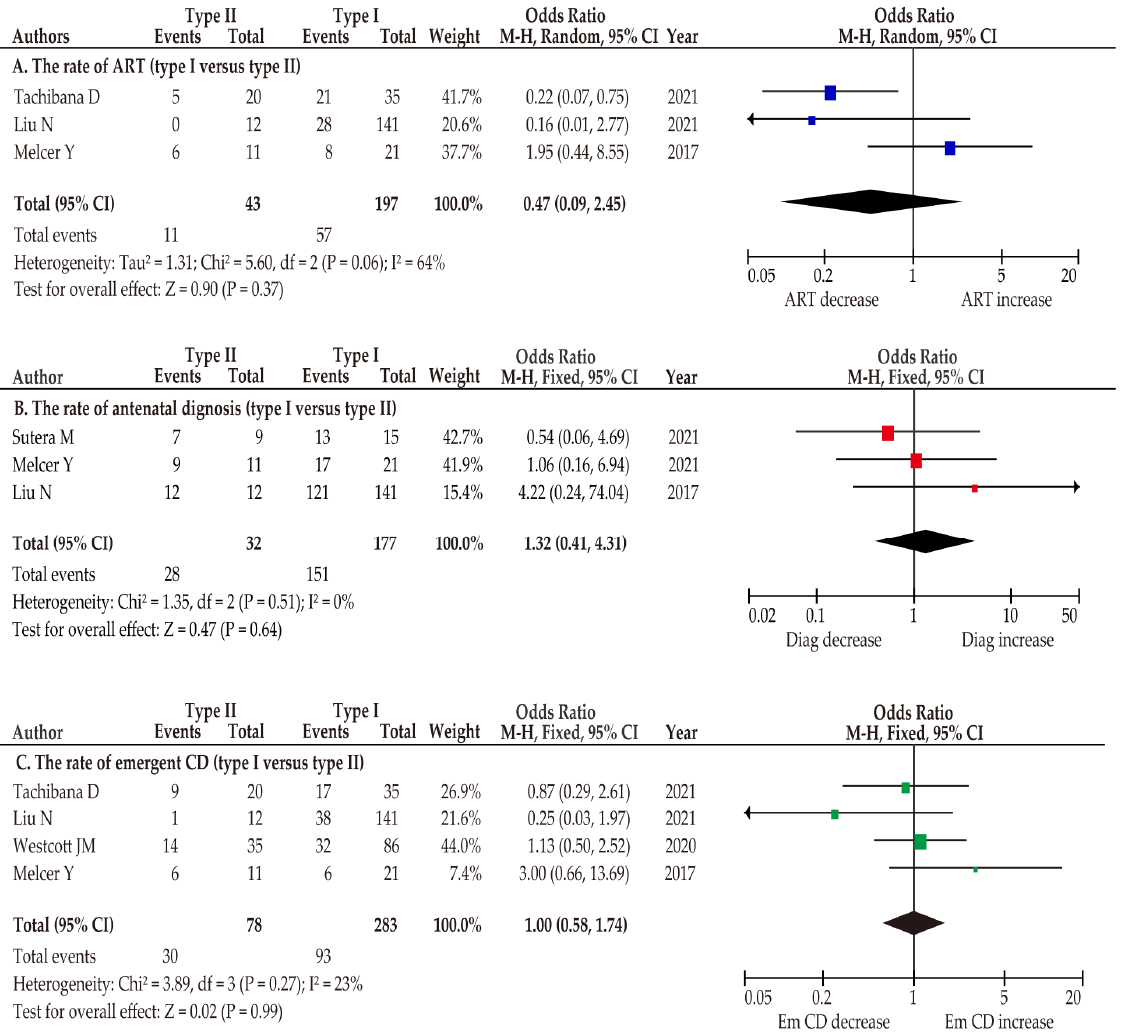
Figure 2. Meta analysis of the characteristics and outcomes of type I and type II vasa previa. The pooled odds ratios for ( A ) the rate of ART (unadjusted), ( B ) the rate of antenatal diagnosis (unad- justed), ( C ) the rate of emergent cesarean delivery (unadjusted), and ( D ) gestational age at delivery between women with type I and type II vasa previa are shown. Forest plots were ordered by the year of publication and relative weight (%) of the study within the strata. The heterogeneity among the studies in each analysis was as follows: substantial heterogeneity ( A : I 2 = 6 4 %) in the unadjusted analysis, no heterogeneity ( B : I 2 = 0%) in the unadjusted analysis, low heterogeneity ( C : I 2 = 23%) in the unadjusted analysis, and substantial heterogeneity ( D : I 2 = 70%) in the unadjusted analysis. The above results were calculated using RevMan ver. 5.4.1 and may differ slightly from the original values. Abbreviations: CI, confidence interval; ART, assisted reproductive technology; Emergent CD, emergent cesarean delivery; GA, gestational age.